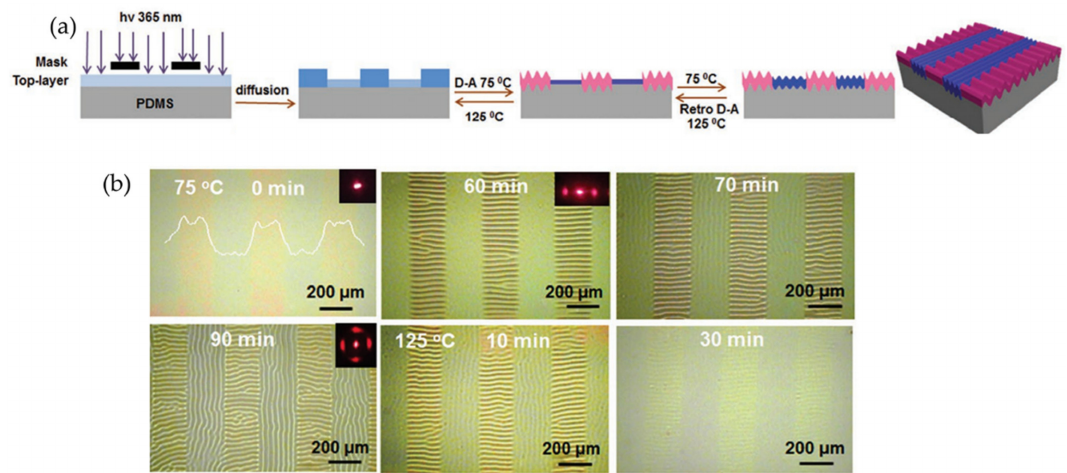
Figure 37. ( a ) Schematic description of the process used for fabricating hierarchical patterns with dynamic wrinkles through a photo-controlled Diels-Alder reaction and ( b ) optical images of the formation/extinction process of horizontally or vertically striped wrinkles on reversible Diels-Alder reaction. Reproduced with permission from [150]. Copyright 2020, John Wiley & Sons,